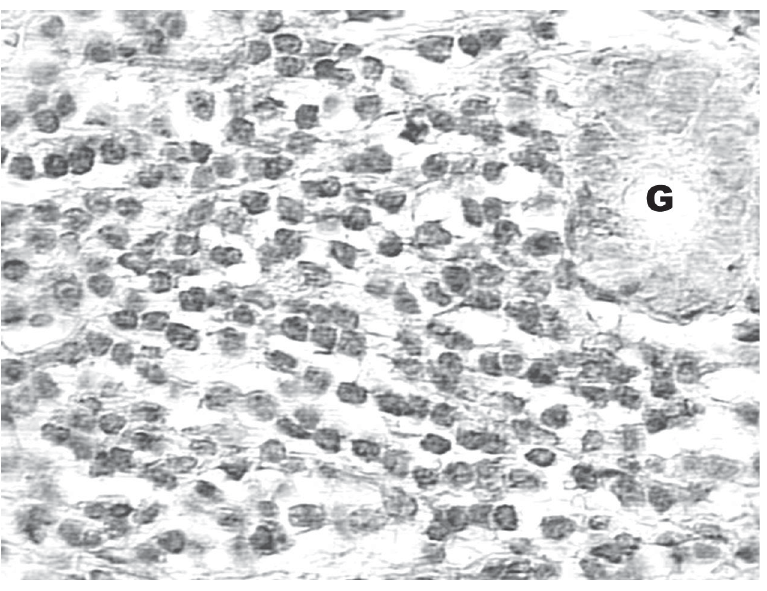
Figure 2. MALT lymphoma: neoplastic lymphocytes and glandular epithelium (G) are negative for reaction with anti-CD95/APO1 (800X; bar 12.5